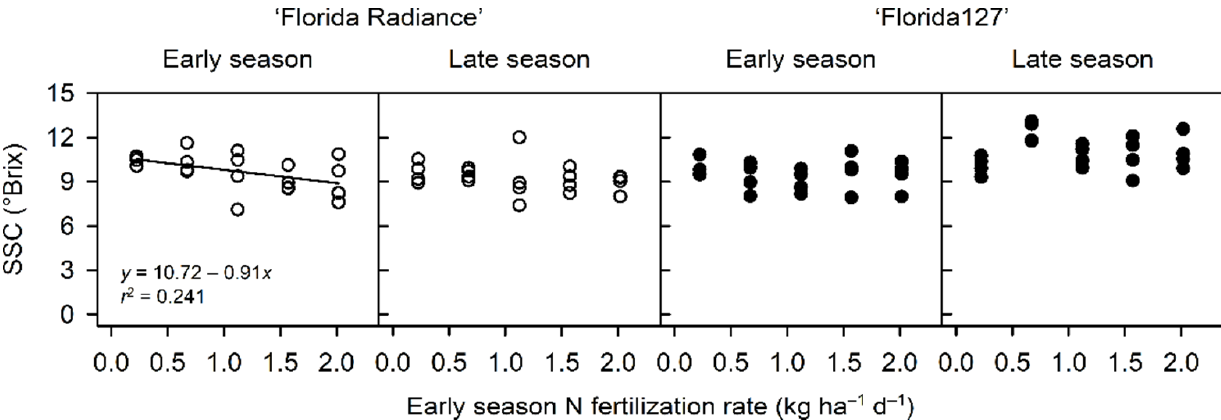
Figure 6. Fruit soluble solids concentration (SSC) responses of two strawberry cultivars to different early-season nitrogen (N) fertilization rates in the 2014–2015 growing season. Treatments are as described in Table 2. Five models were fit to each data set: linear, quadratic, exponential plateau, exponential decay, and sigmoidal models. Only the significant ( p ≤ 0.05) and best-fit model is shown for each data set. No regression line is shown when none of the models had a significant fit. Early season = November–December. Late season = January–February.